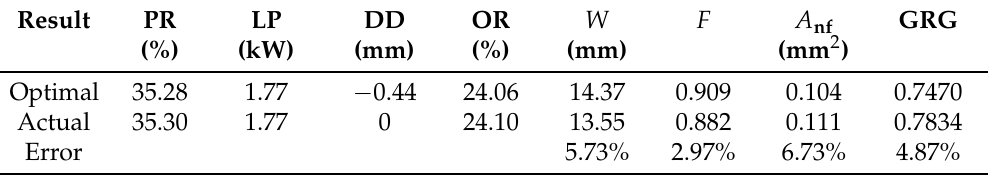
Table 15. Verification results of proposed response surface